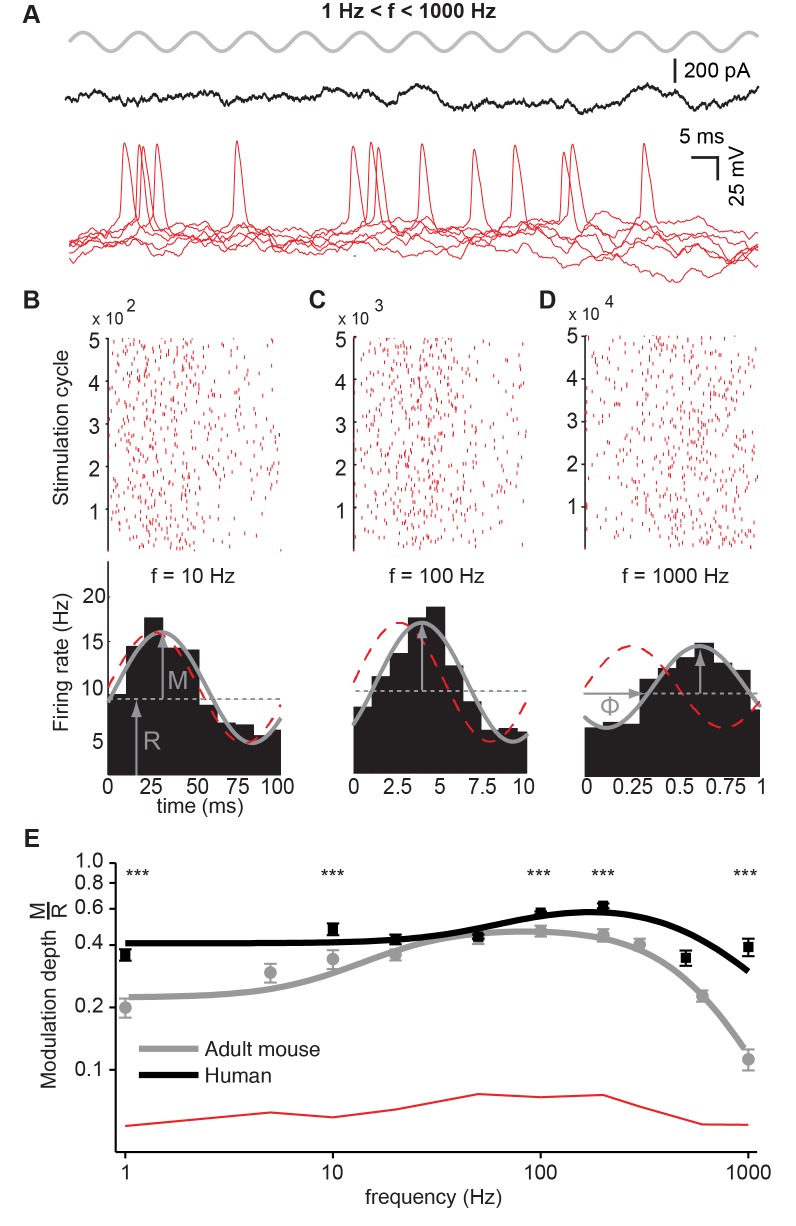
Human pyramidal neurons track input signals beyond 500 cycles/s.(A) Top trace (gray): weak amplitude sinusoidal currents, injected with distinct oscillation periods (1–1,000 cycles/s). Middle trace (black): injected randomly fluctuating additional current component. Lower trace: AP firing by human pyramidal neuron in response to the total injected current. (B–D) Across successive cycles and for distinct sine input oscillations (10, 100, 1,000 cycles/s), APs fired by a human pyramidal neuron are displayed in raster diagrams (B–D, upper panels) and are quantified by a peristimulus time histogram (PSTH, lower panels), which estimates the instantaneous firing probability. (E) Modulation depth (i.e., peak modulation magnitude over the mean rate, M/R) as a function of Fourier frequency for human (n = 13, black) and mouse cells (n = 14, gray). Larger frequencies imply faster input oscillations. Markers indicate mean ± SEM, while the thick solid traces are fits obtained with a rational complex function (see the Materials and Methods and Methods S1). The red line indicates the significance level for the data, obtained by computing the modulation depth over surrogate data, obtained shuffling the interspike intervals. (Data deposited in the Dryad repository, http://doi.org/10.5061/dryad.3723p
[56]: Raw data underlying A–E and Figure S3 in Data_Fig4_and_SFig3_Human.rar and Data_Fig4_and_SFig3_Mouse_Part1 to Part4.rar; scripts used for analysis and that generated (A–E) are also included in Data S4.xlsx).